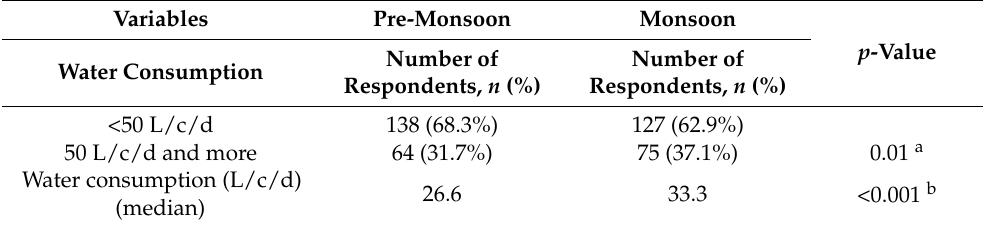
Figure 2. Proportion of households with types of water source used during pre-monsoon ( N = 209) and monsoon seasons ( N = 209). Table 1. Household characteristics with water use.